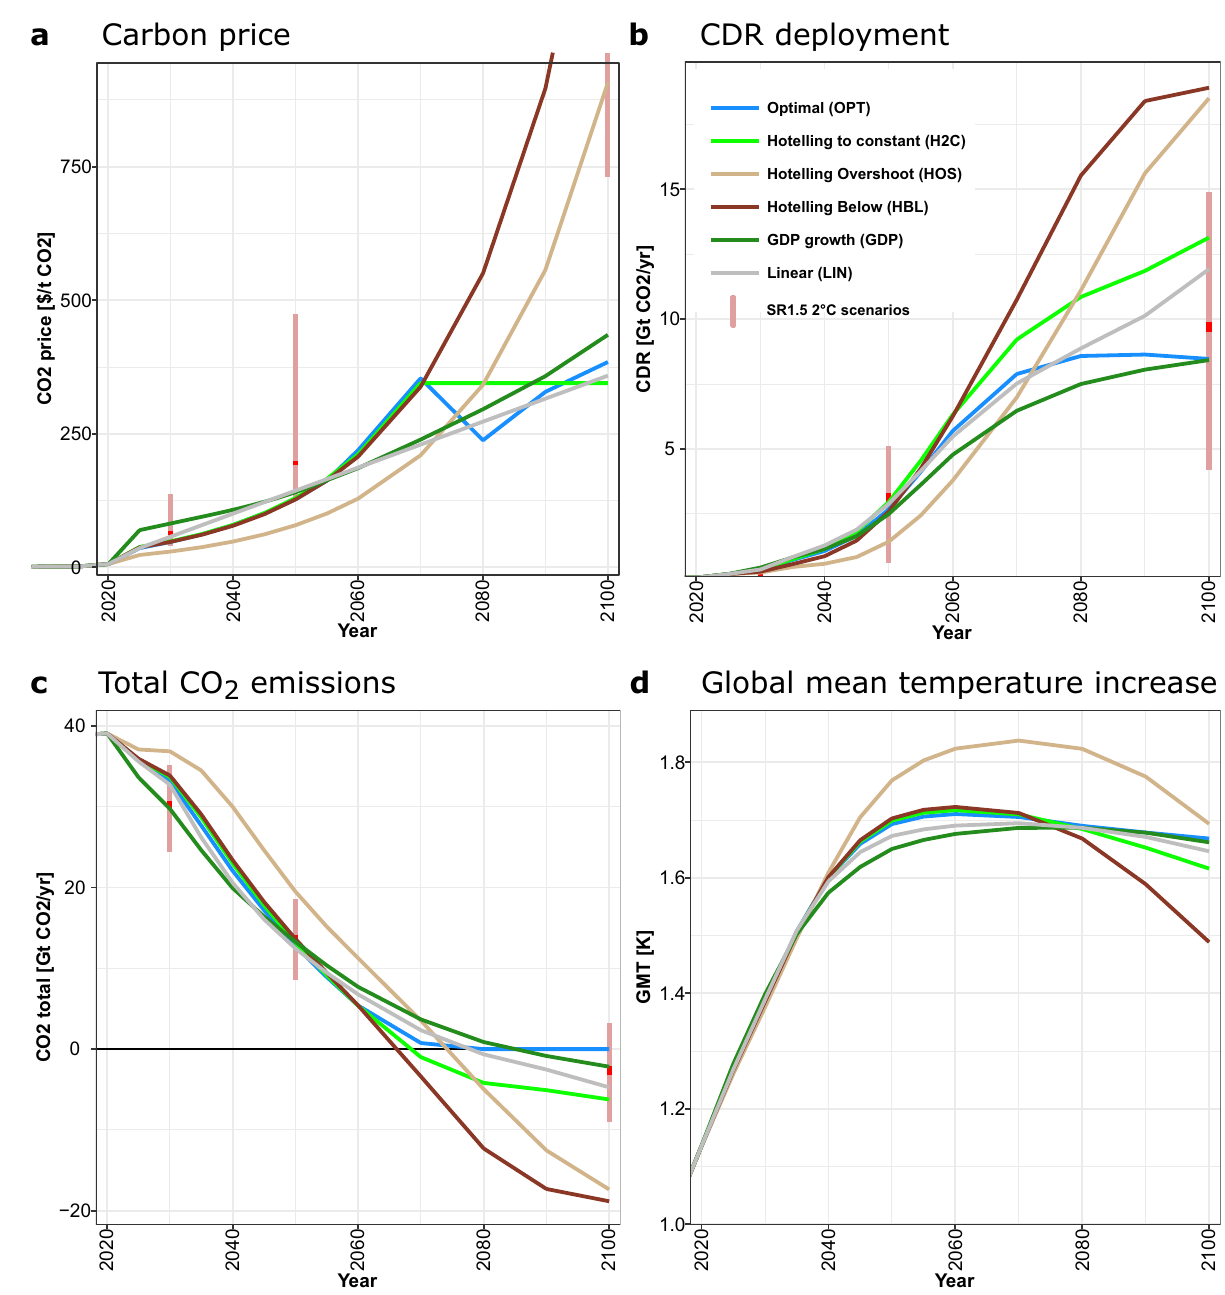
Fig. 1 Characteristics of the six scenarios. a Carbon price, b Carbon Dioxide Removal deployment, c total CO 2 emissions, and d global mean temperature increase for the Optimal (blue), Hotelling to Constant (light green), Hotelling Overshoot (light brown), Hotelling Below (dark brown), GDP Growth (dark green), and Linear (gray) scenarios. The red circles and bars show the median and the interquartile range of the SR1.5 2 °C scenarios (i.e. categories “ Lower 2C ” and “ Higher 2C ” ),